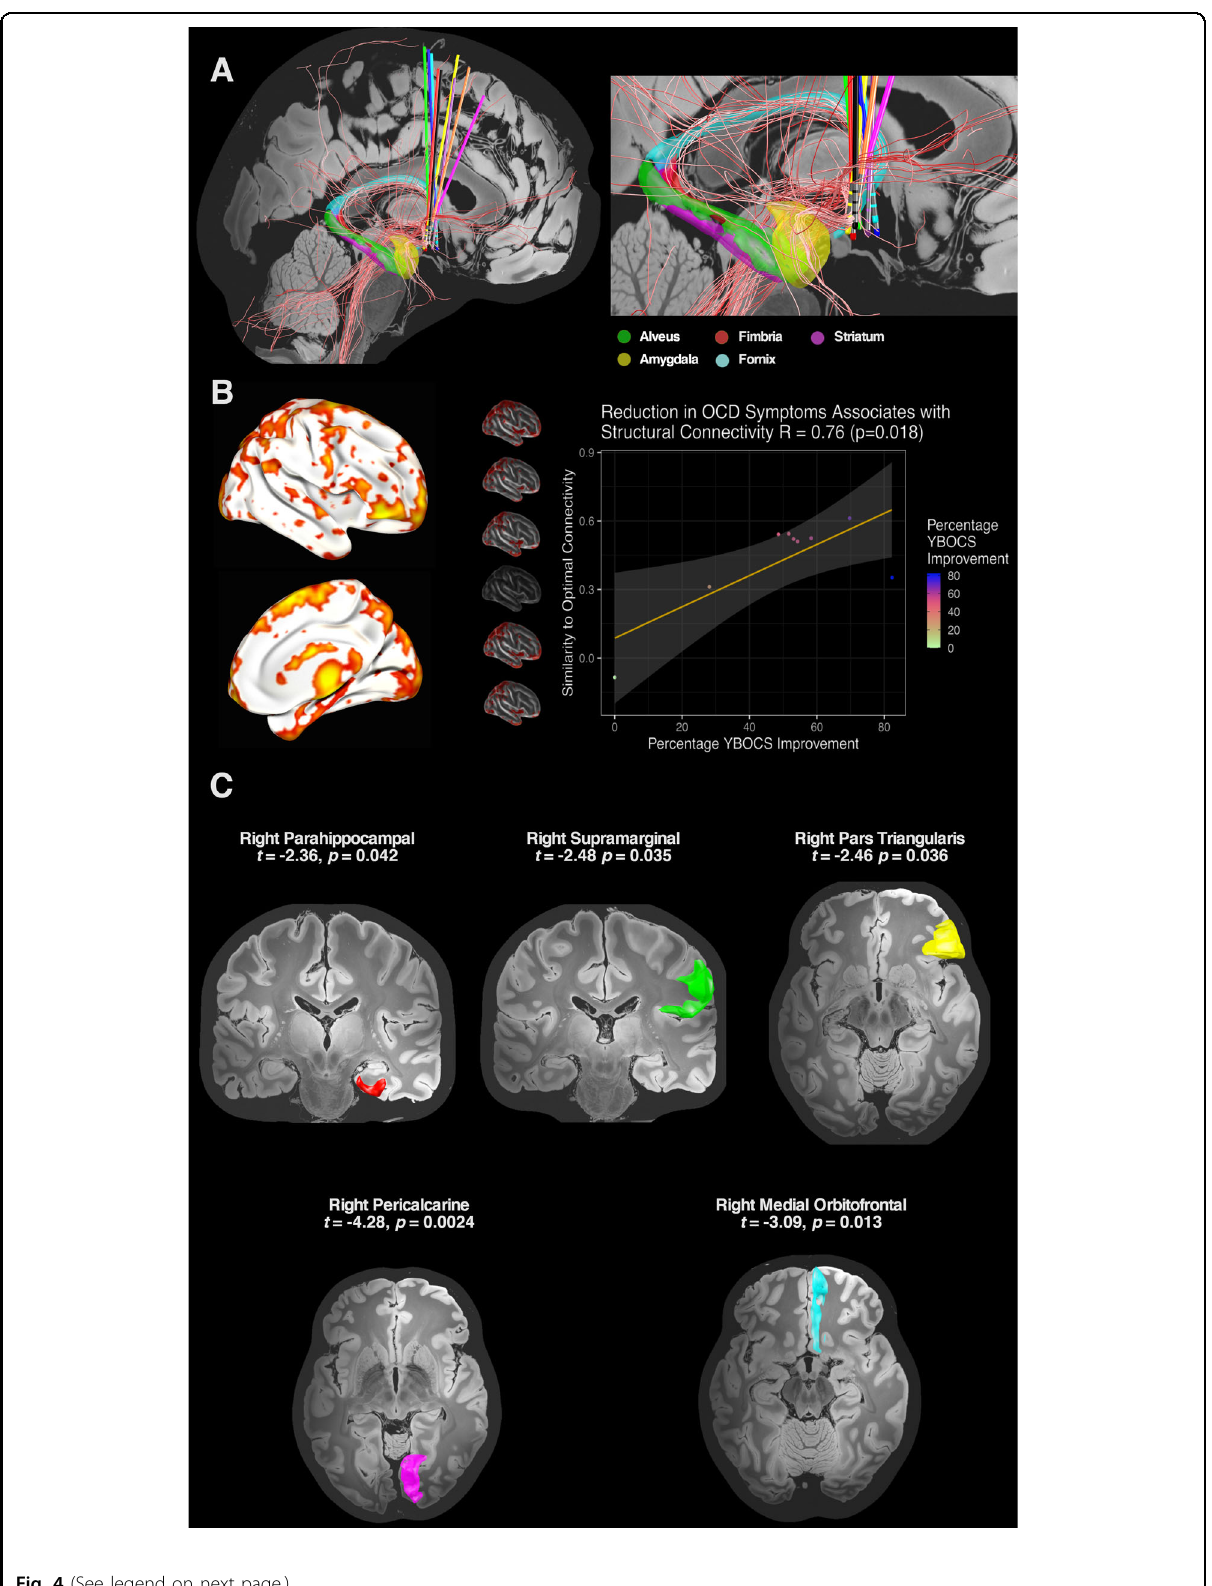
Fig. 4 (See legend on next